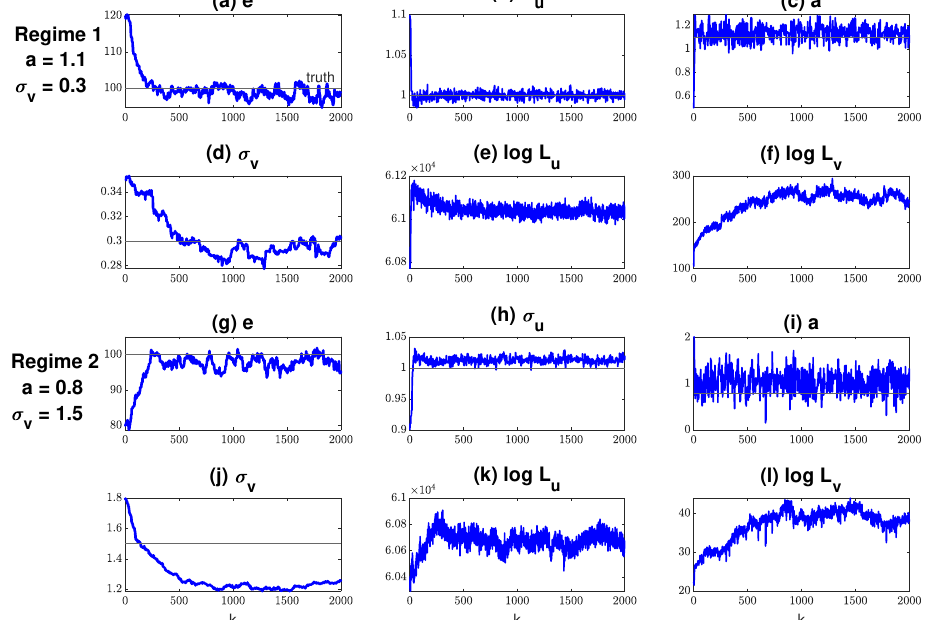
Figure 5. Trace plot of the estimated parameters in the stochastically coupled FHN model (14) for dynamical regime 1 (top 2 rows) and 2 (bottom 2 rows). ( a – d , g – j ) the trace plots of the parameters e , σ u , a , and σ v . For reference, the true parameter values are shown by the black lines; ( e , k ) the trace plot of the log-likelihood of the observation of u , according to (5); ( f , l ) the trace plot of the log-likelihood for the hidden path of v , according to